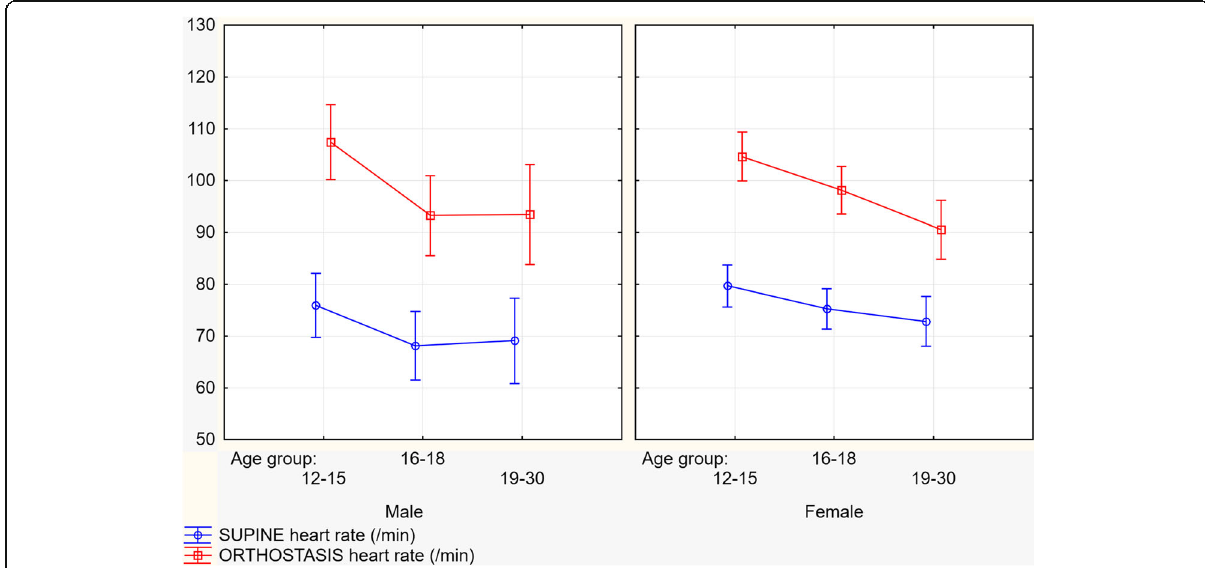
Fig. 1 Heart rate dynamics between gender from supine to the upright position during tilt-up test